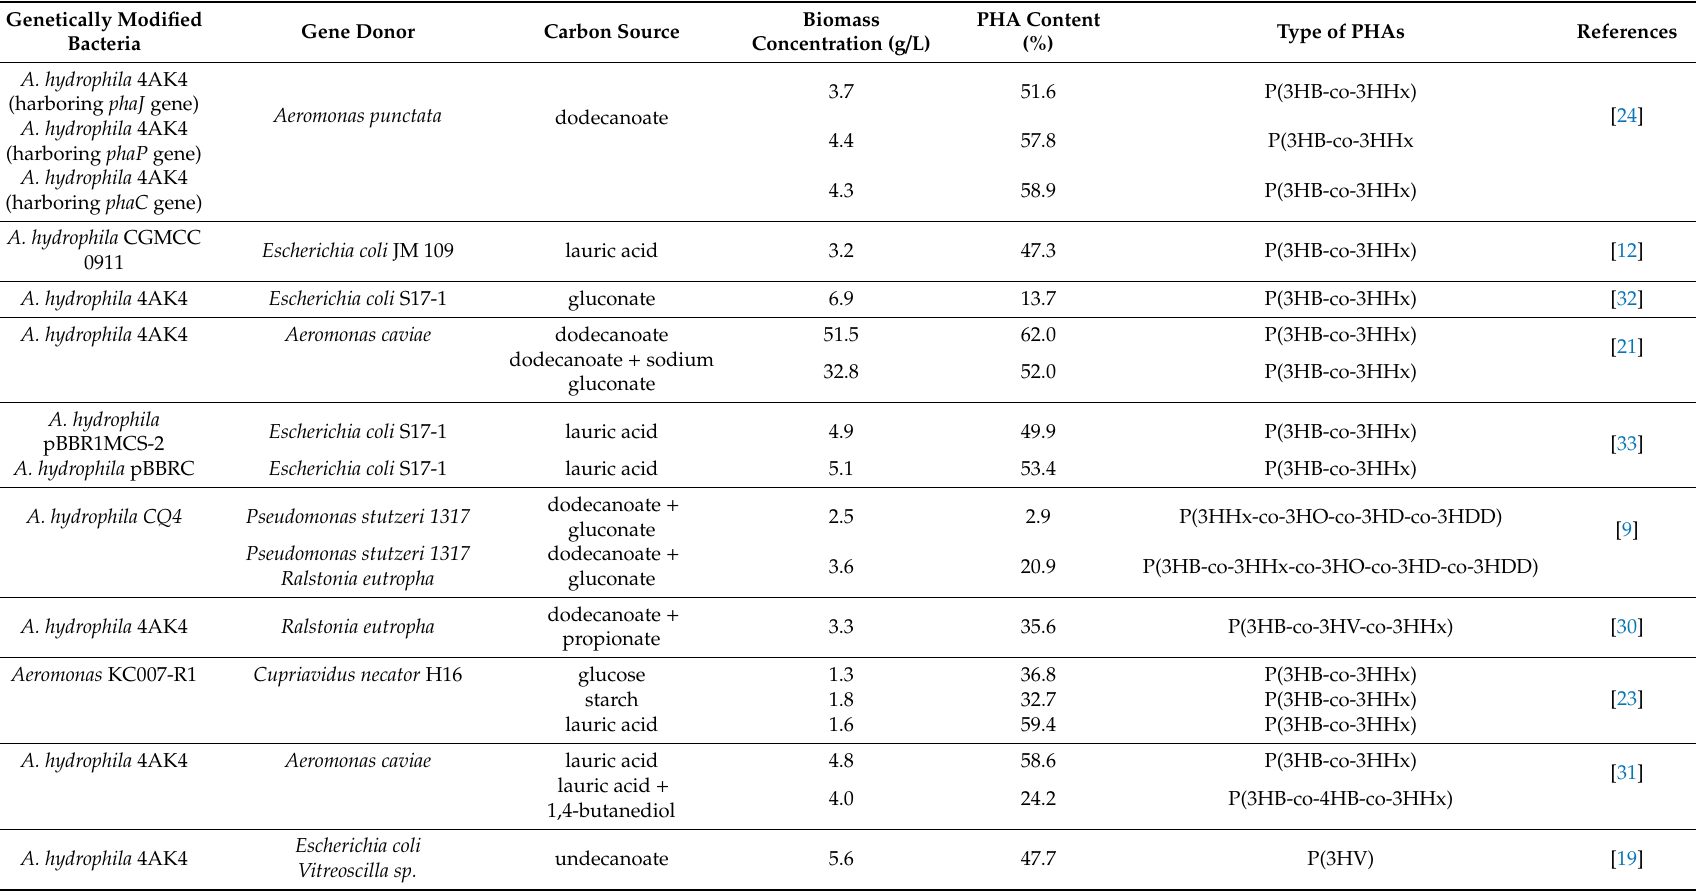
Table 2. PHAs production by genetically modified Aeromonas